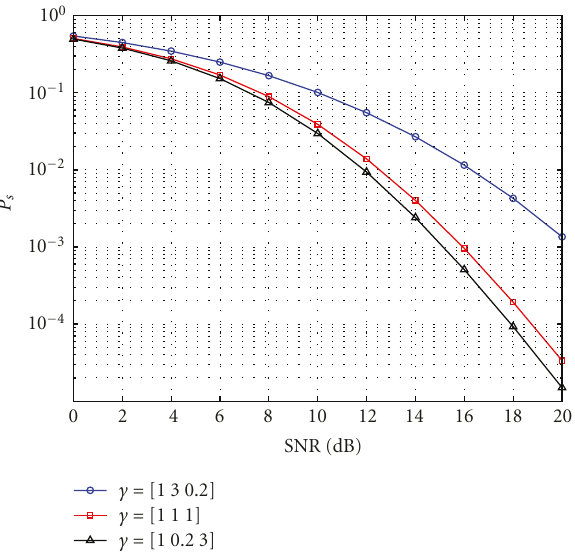
Figure 3: Average symbol error probability versus average SNR per bit for 16-QAM signals with di ff erent K values and independent Nakagami- m fading channel ( m = 1).